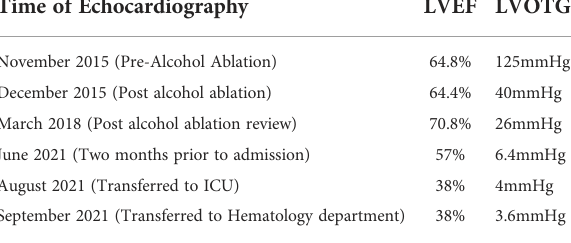
TABLE 1 Summary of patient echocardiographic changes. Time of